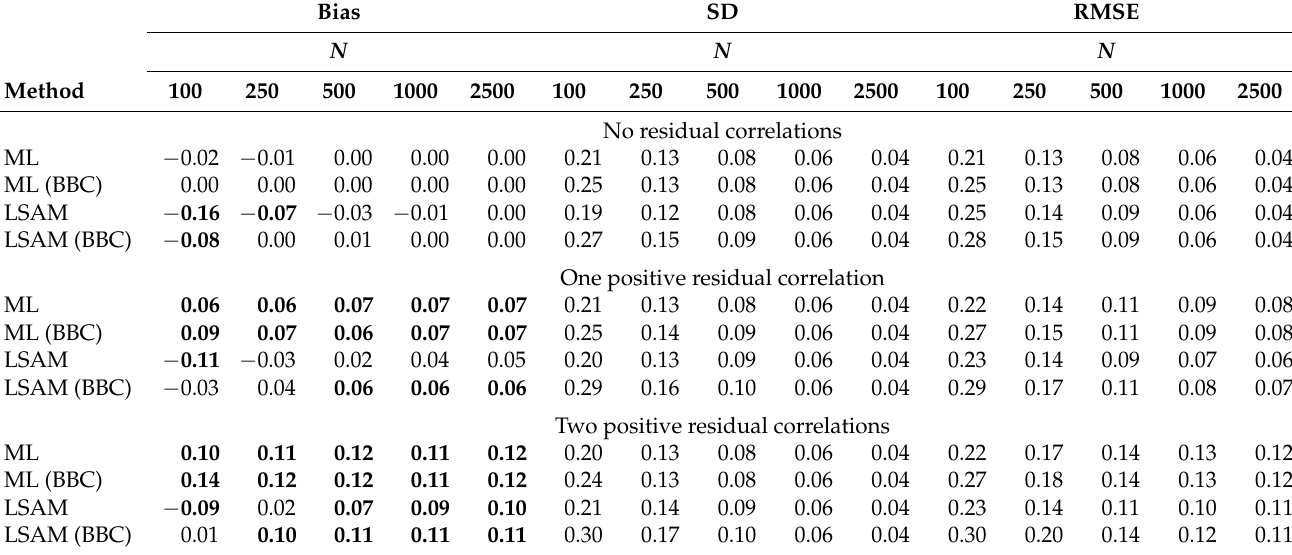
Table 5. Focused Simulation Study 1C (two factors and residual correlations): bias, standard deviation (SD), and root mean square error (RMSE) of estimated factor correlation as a function of sample size with no, one positive and two positive residual correlations in the data-generating model.